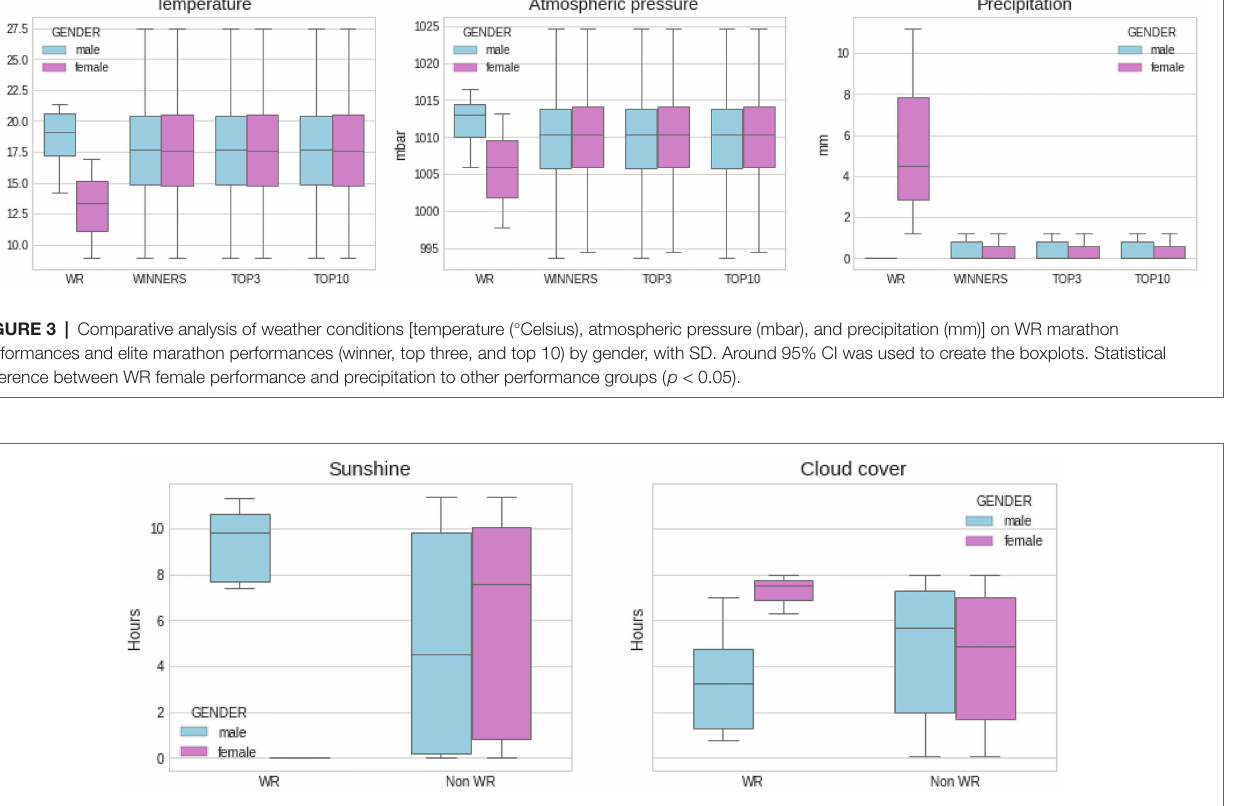
FIGURE 4 | Comparative analysis of weather conditions (sunshine and cloud cover in hours) on WR marathon performances and non WR marathon performances by gender, with SD. About 95% CI was used to create the boxplots. Statistical differences between female WR and other groups for sunshine and cloud cover ( p <